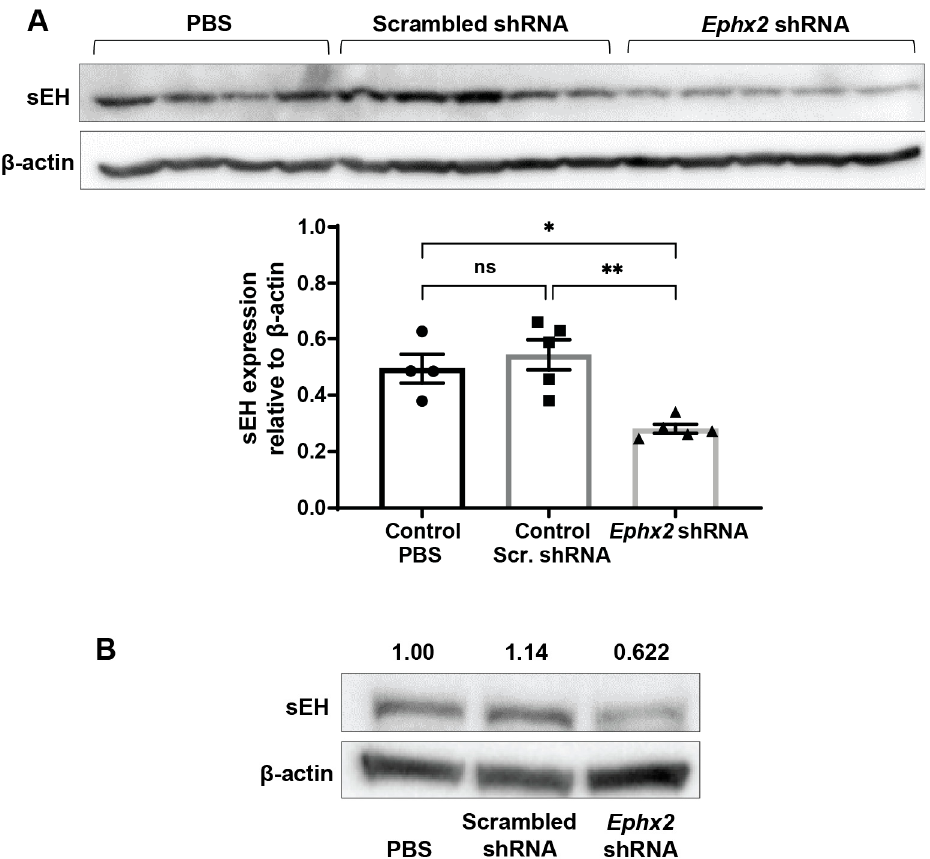
Figure 7. AAV8- Ephx2 shRNA reduces sEH expression level. Inhibitory effect of AAV8- Ephx2 shRNA on sEH expression was determined in tissues collected 21 days post intravitreal injection of 1.9 × 10 7 GC of AAV8- Ephx2 shRNA, AAV8-scrambled shRNA control or PBS control. ( A ) sEH expression in retina. Each lane represents a single retina sample, with quantification by densitometry. Mean ± SEM, n = 4–5 retinas, one-way ANOVA with Tukey’s post hoc tests (ns, non-significant; * p < 0.05; ** p < 0.001). See Figure S6. ( B ) sEH expression in RPE/choroid. Each lane represents pooled tissue samples from n = 3–4 eyes. See Figure S7. Intensity relative to PBS control, normalized to β -actin, is indicated.